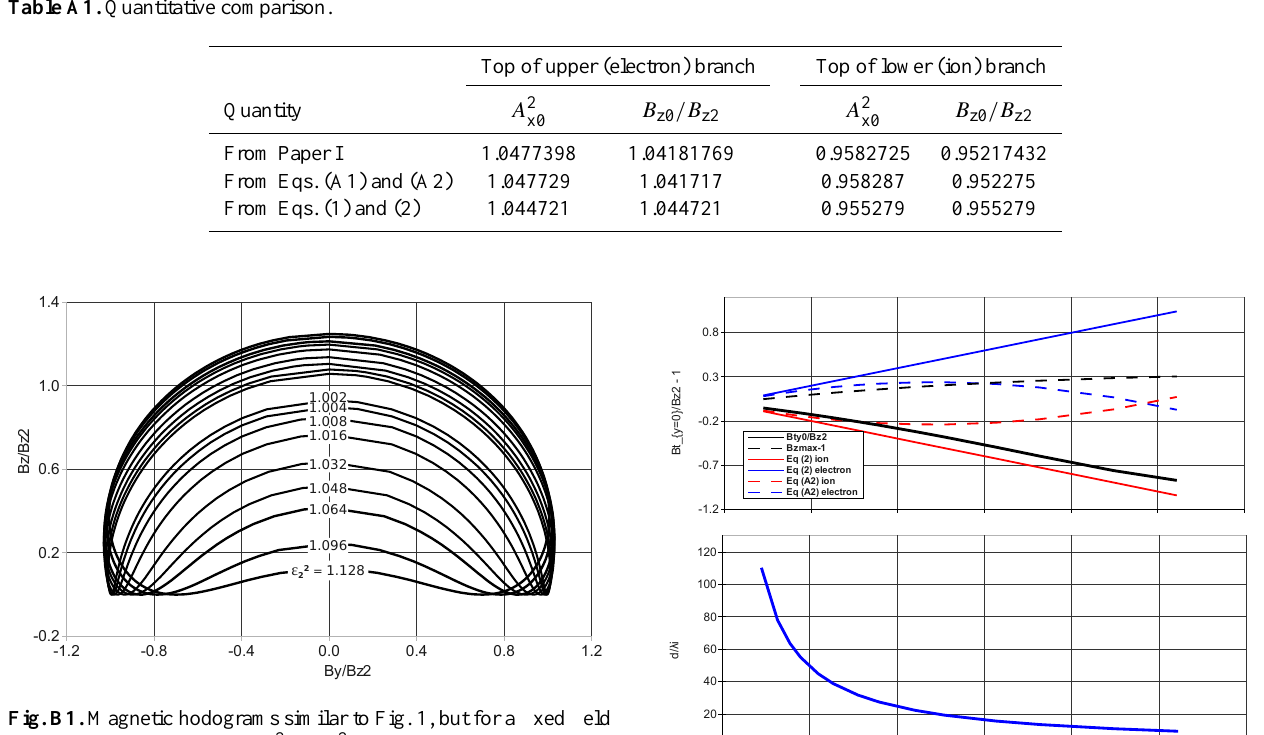
Table A1. Quantitative comparison.